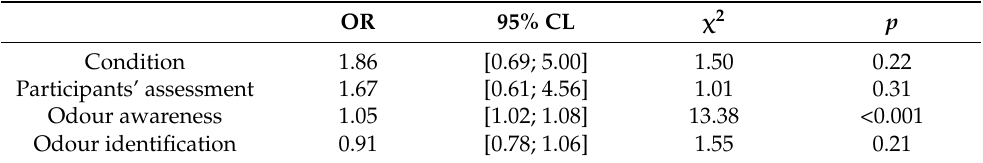
Table 3. The odds ratio (OR) and its 95% confidence limits (CL), χ 2 statistic and p -value for condition (odour/control), participants’ appraisal of the olfactory environment (smell reported/not reported), odour awareness operationalised as the Odor Awareness Scale (OAS) score, and the ability to identify odour assessed by the University of Pennsylvania Odor Identification Test